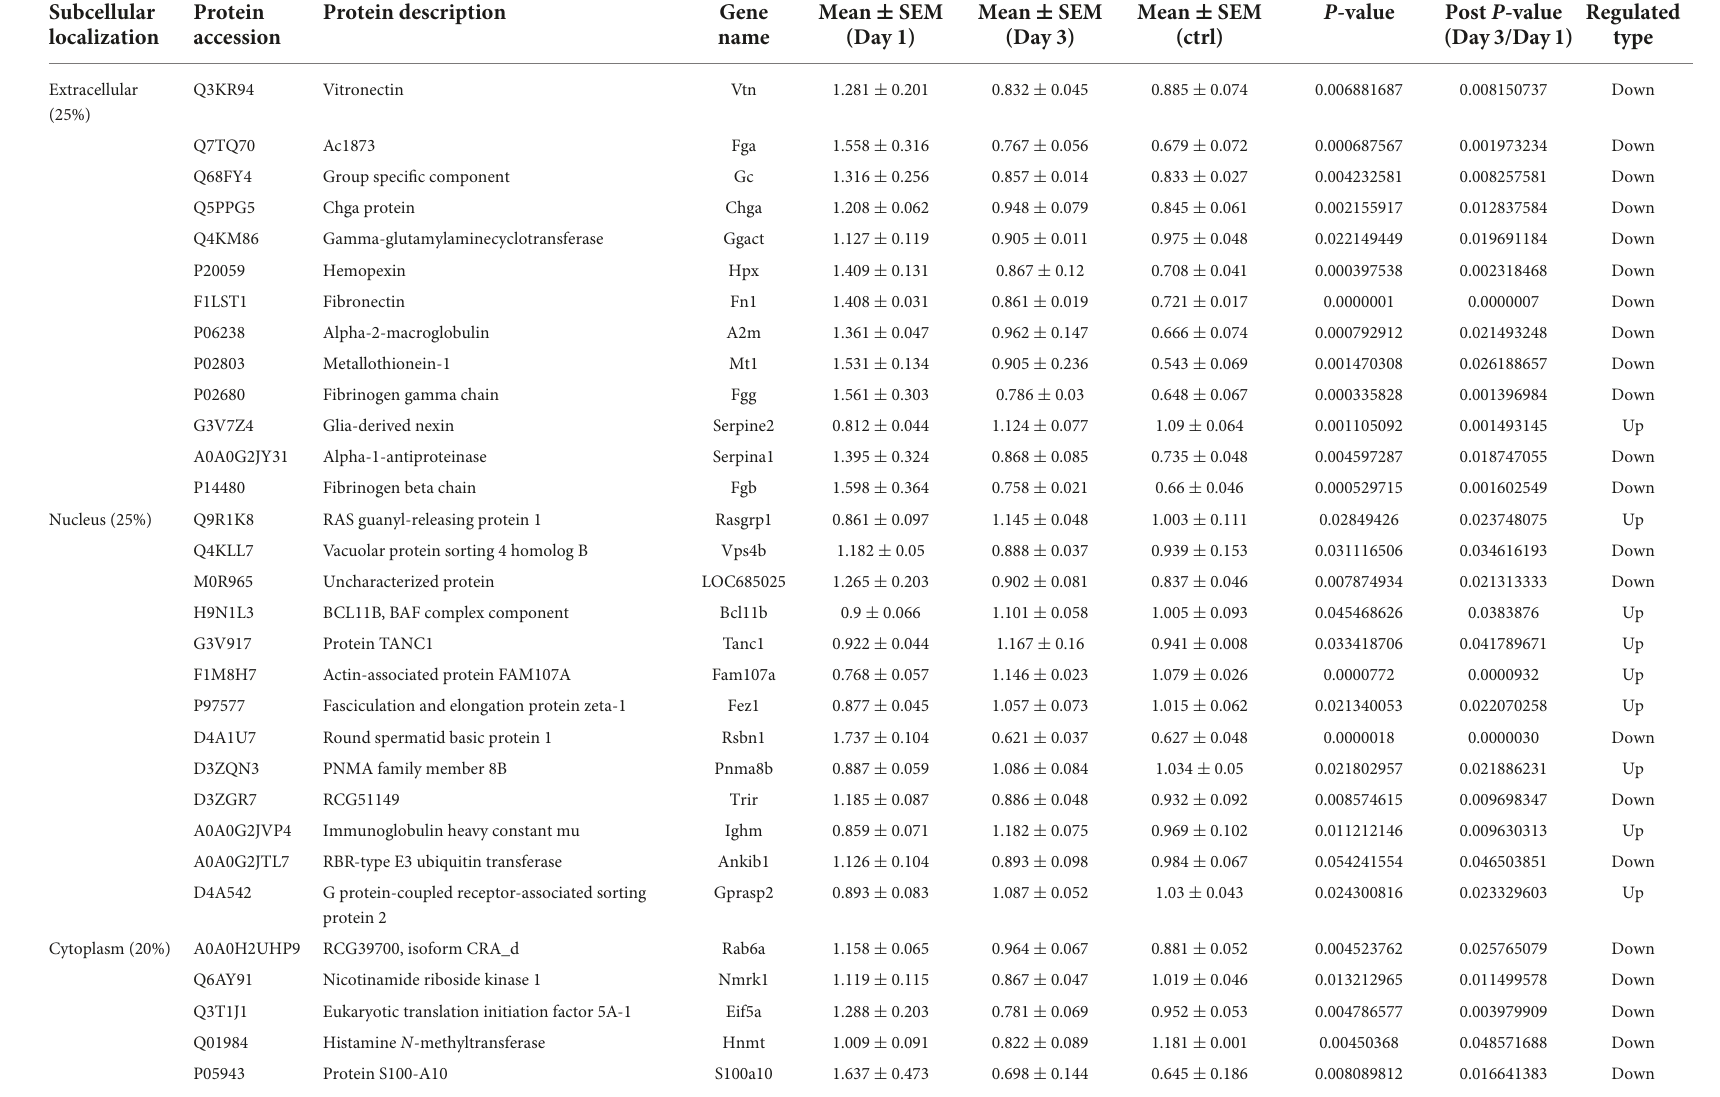
TABLE 6 Cellular distribution of differentially expression proteins on Day 3 comparing with Day 1 by ANOVA analysis in